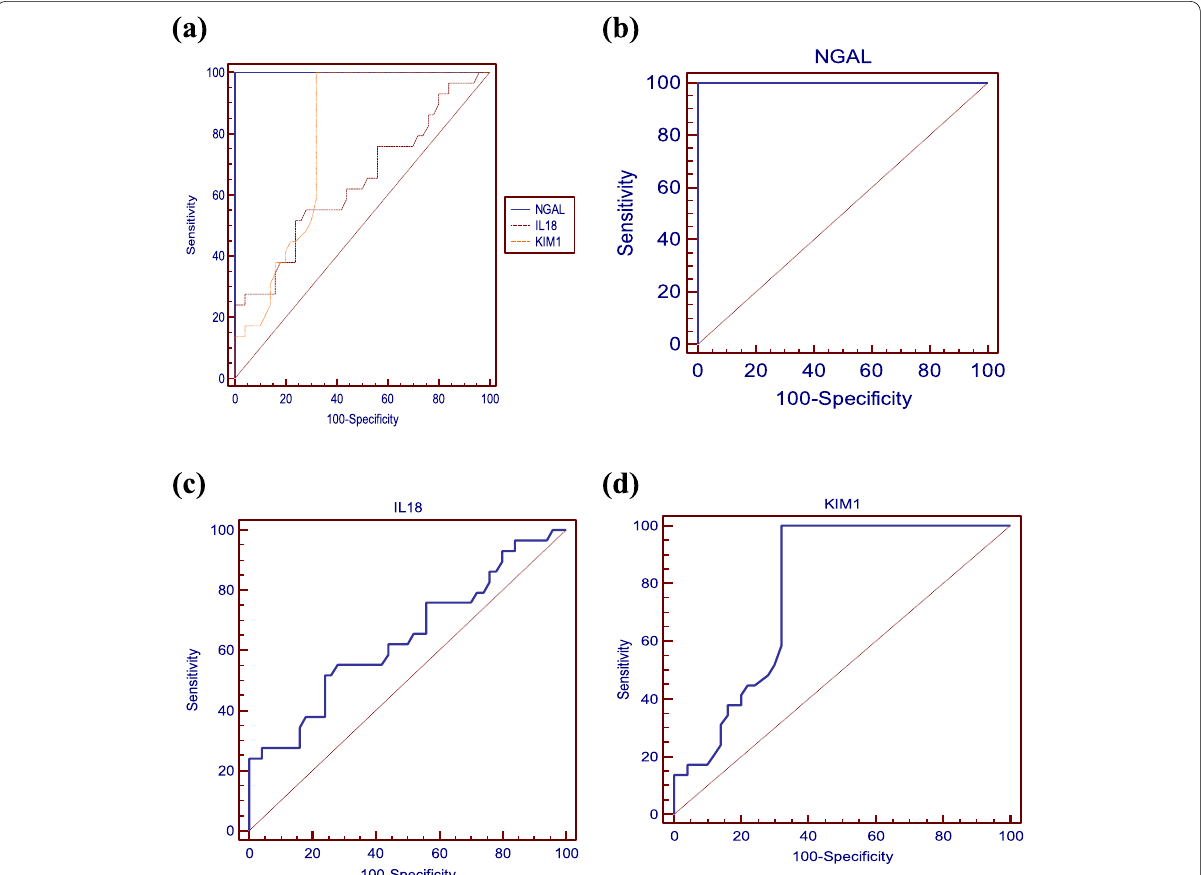
Fig. 5 a ROC curve to evaluate the capability of urinary IL‑18, NGAL, and KIM‑1 for diagnosis stage 1 AKI. b ROC curve to evaluate the capability of urine NGAL for diagnosis of stage 1 AKI. c ROC curve to evaluate the capability of urinary IL‑18 for diagnosis of stage 1 AKI. d ROC curve to evaluate the capability of urinary KIM‑1 for diagnosis of stage 1